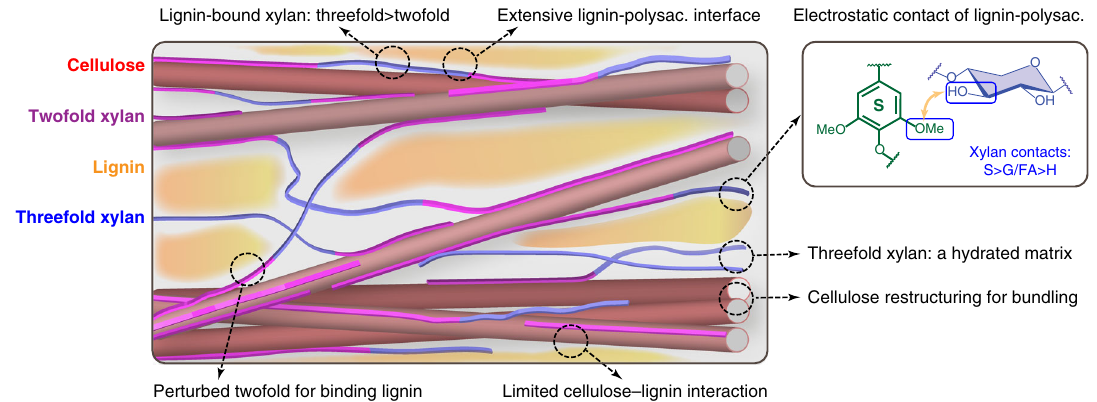
Fig. 6 A revised model of lignin-polysaccharide packing and secondary cell wall architecture. Cellulose micro fi brils, two-fold and three-fold xylan, and lignin are depicted in red, purple, blue and yellow, respectively. The secondary cell wall adopts much tighter packing than the primary cell walls, and the two hydrophobic cores of lignin and cellulose are bridged by xylans in a conformation-dependent manner. The key fi ndings of this study have been annotated in the model, with the corresponding spots highlighted using dashline circles. The representative polar motifs responsible for lignin-xylan interactions are boxed in blue. Polysaccharides are abbreviated as polysac. The depiction may not be to